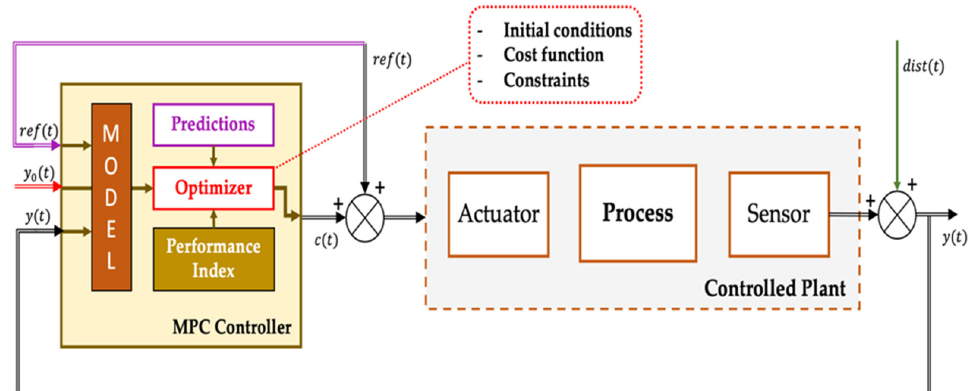
Figure 5. MPC closed control loop.